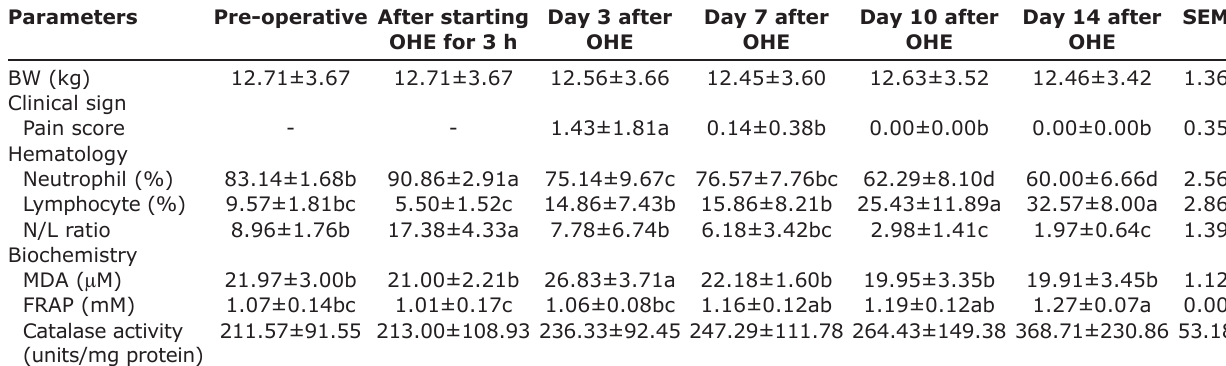
Table-1: Effect of duration on pain stress, hematological changes, and biochemical values before, during, and after OHE in female dogs. Parameters Pre-operative After starting OHE for 3